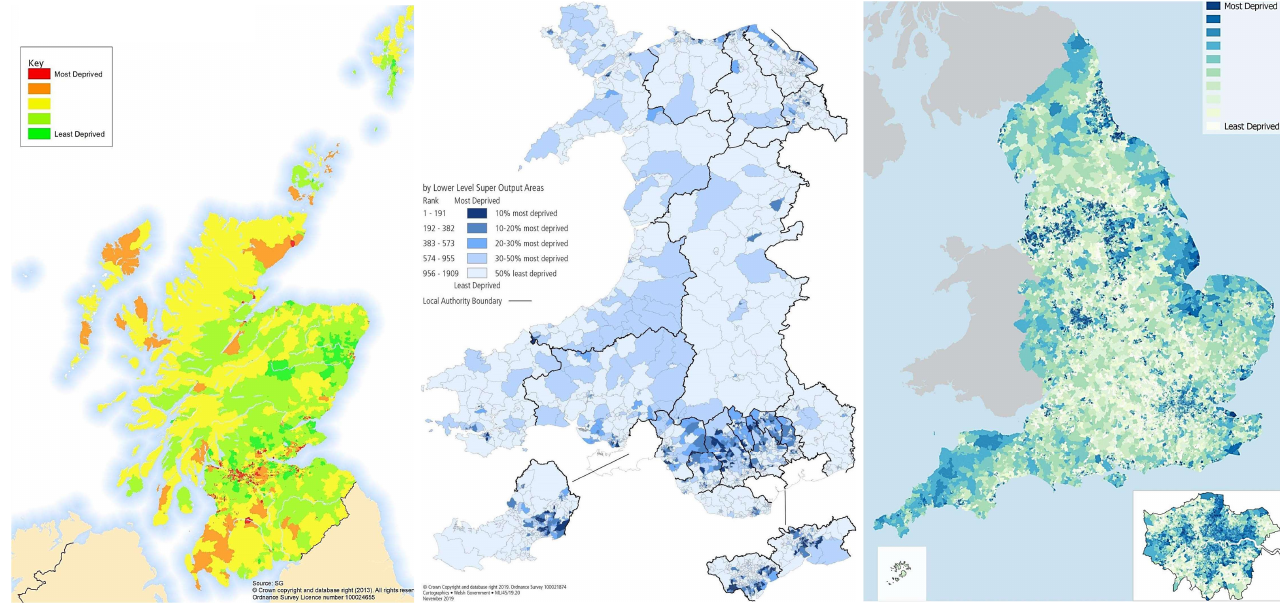
Figure 1. Index of multiple deprivation for Scotland, Wales and England. Darker regions display areas of most deprivation. Former industrial areas have the highest levels of most deprived areas. 1 London has a disproportionate influence over the national UK GDP per capita. It has been estimated that for New York to have the warping effect on the US economy that London has on the UK, it would need to have a population of 65 million. London’s urban metropolitan area (which encompasses commuters) is larger than Greater London—this is an